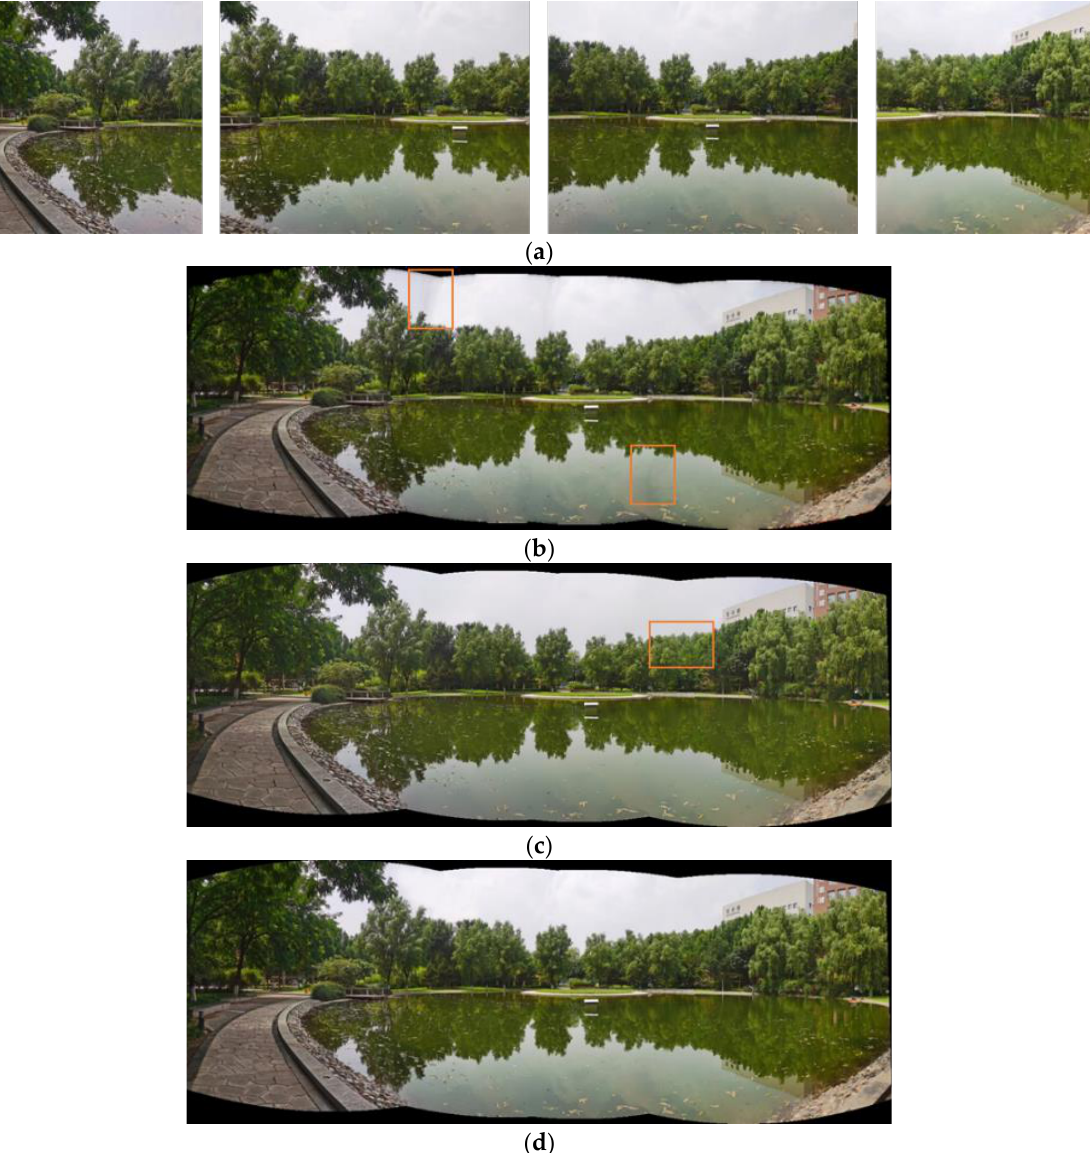
Figure 13. Artificial lake images: ( a ) input images; ( b ) panorama by optimal seam + fade-in and fade-out weighted method; ( c ) panorama by optimal seam + multi-resolution method; ( d ) panorama by the proposed method.